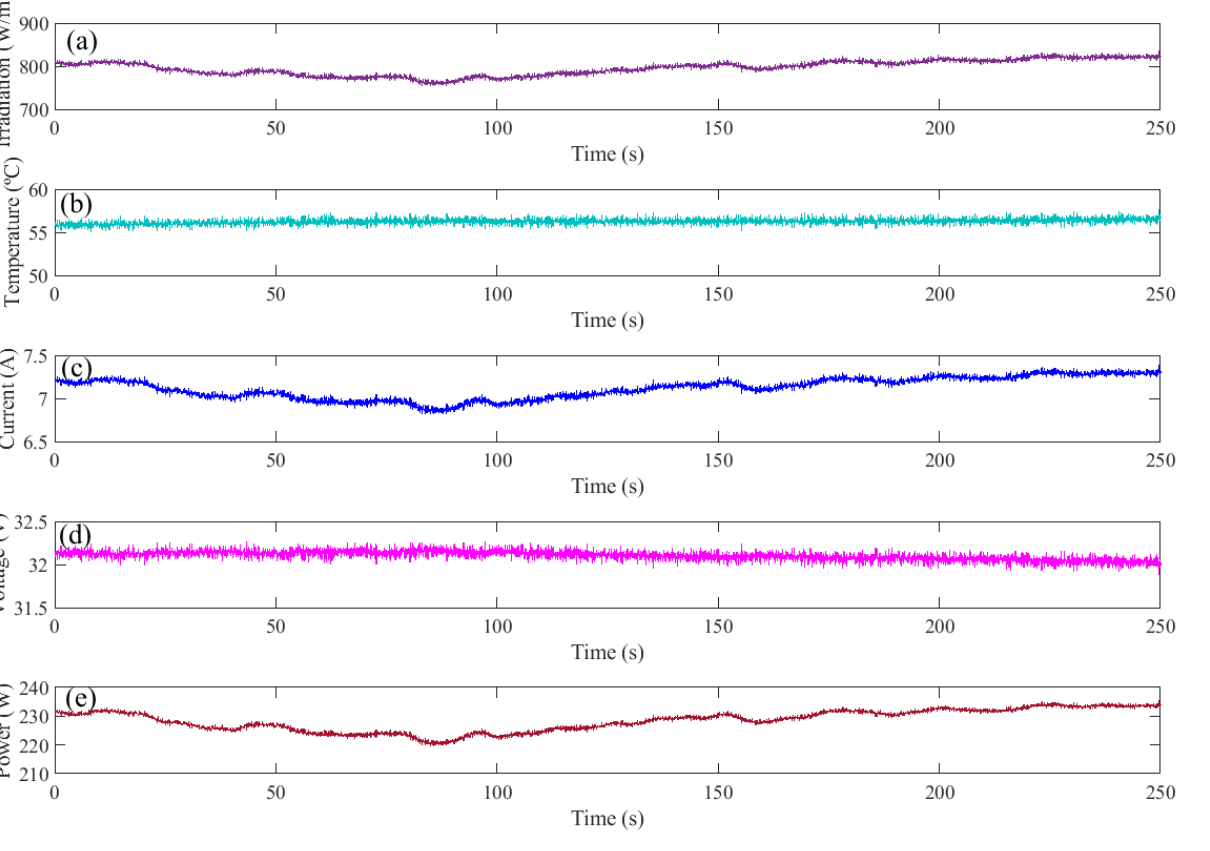
Figure 16. MPPT based on RNN and SMC: ( a ) Irradiation (W/m 2 ); ( b ) Temperature ( ◦ C); ( c ) PV current; ( d ) PV voltage; ( e ) PV